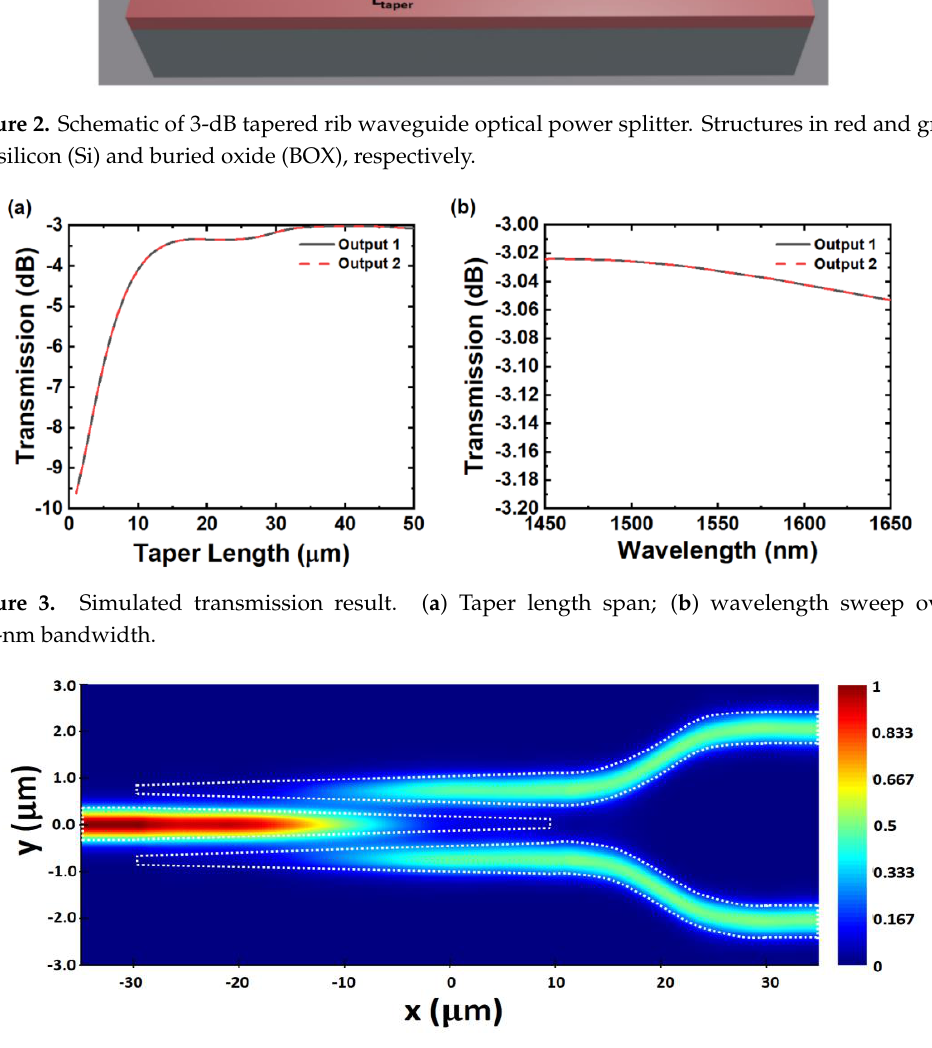
Figure 4. The E-field intensity profile of 3-dB optical power splitter. The field values in the legend are normalized values.